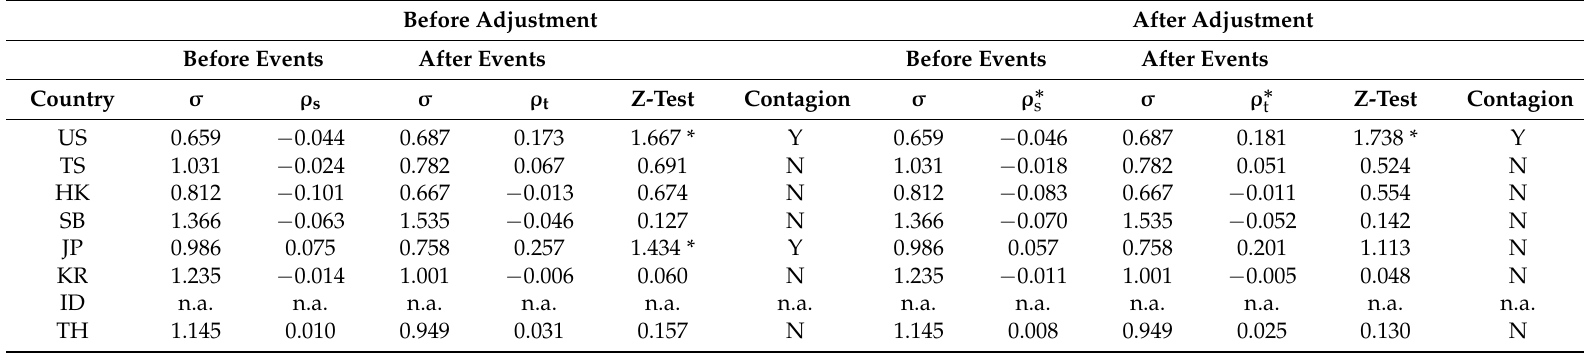
Table 8. The Correlation Coefficients after heteroscedasticity biases adjustment: South Asian tsunami. Before Adjustment After Adjustment Before Events After Events Before Events After